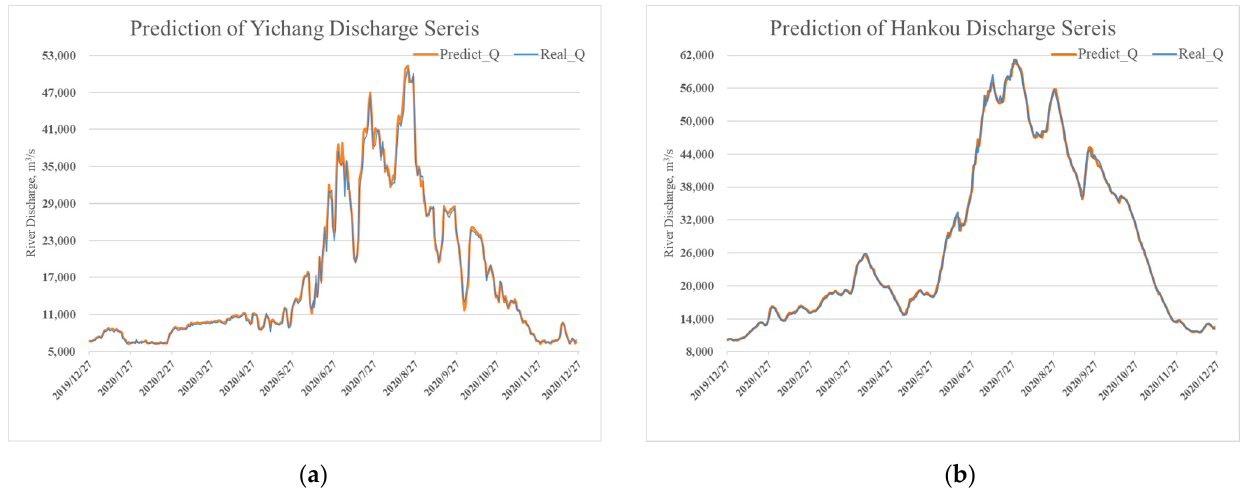
Figure 6. The prediction and observation data of discharge series. ( a ) The predicted result for Yichang Hydrological Station; ( b ) the predicted result for Hankou Hydrological Station.